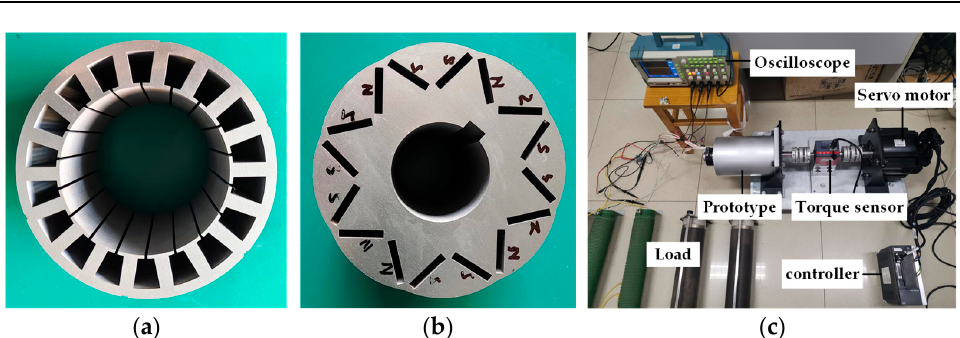
Figure 17. Prototype and experimental platform: ( a ) stator; ( b ) rotor; and ( c ) experimental platform.